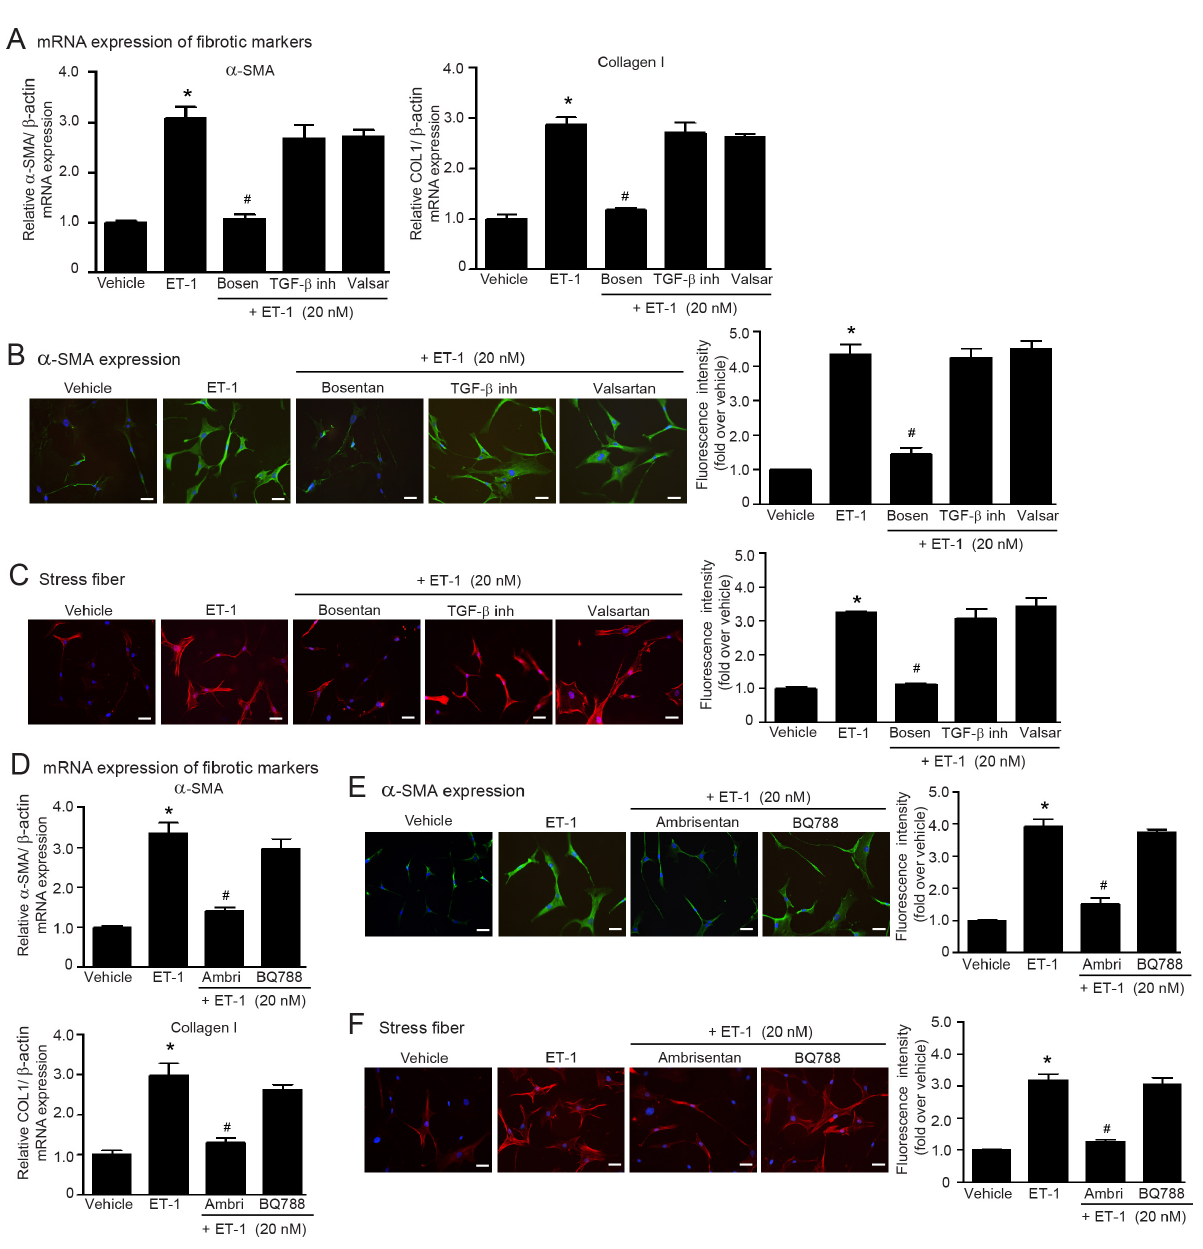
Figure 4. ET-1 acts as a downstream effector of Ang II and TGF- β 1, which induces α -SMA and collagen I expression and stress fiber formation through the ET A Rs. ( A – C ) Serum-starved adult HCFs were incubated with LY2109761 (TGF- β inh; 5 µM), bosentan (1 µM), or valsartan (valsar; 1 µM) for 1 h before stimulation with 20 nM ET-1 for 6 h ( A ) or 24 h ( B , C ). ( D – F ) Serum-starved adult HCFs were pretreated with 1 µM ambrisentan (ambri; ET A R antagonist) or 1 µM BQ788 (ET B R antagonist) for 1 h before stimulation with 20 nM ET-1 for 6 h ( D ) or 24 h ( E , F ). ( A , D ) Relative mRNA levels of fibrotic markers, α -SMA, and collagen I were analyzed by qRT-PCR. Data are expressed as the mean ± SEM ( n = 4). After treatment, immunofluorescence staining was used to determine α -SMA expres- sion (green) ( B , E ) and stress fiber formation (red) ( C , F ). Nuclei were stained with DAPI (blue). Scale bar, 10 µm. Data are expressed as the mean ± SEM ( n = 3). * p < 0.05 vs. vehicle; # p < 0.05 vs. ET-1. In addition, ET-1 binds to ETRs, including ET A R and ET B R, and exerts its effects on tissue fibrosis [31]. Here, we also determined the subtype specificity of ETRs in ET-1-in- duced myofibroblast differentiation in adult HCFs. Pretreatment of fibroblasts with am- brisentan (ET A R antagonist), but not BQ788 (ET B R antagonist), was able to antagonize ET- 1-induced α -SMA and collagen I synthesis and stress fiber formation (Figure 4D–F). Col- lectively, ET-1 acts as a downstream target of the Ang II/TGF- β 1 cascade by binding to and activating the ET A R subtype to promote myofibroblast differentiation.